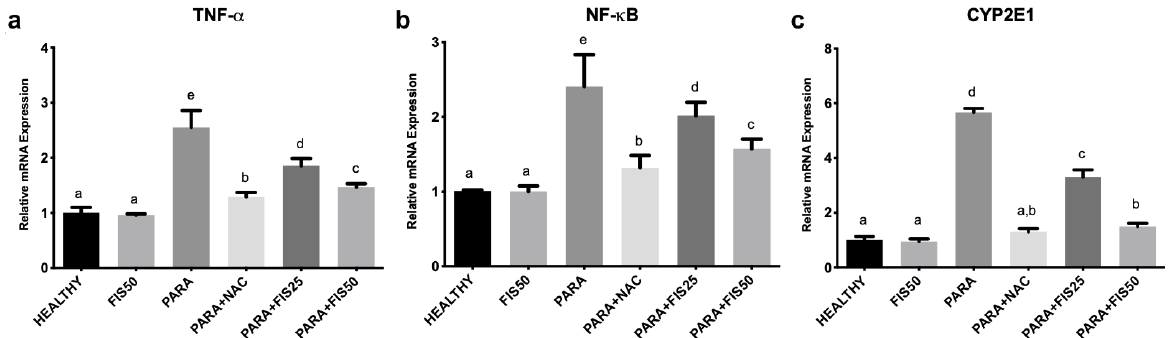
Figure 3. The Results of Relative mRNA Expression of TNF-α, NF-κB and CYP2E1. a: TNF-α, b: NF-κB, c: CYP2E1. Means with the same letter are not significantly different; means with different letters indicate significant differences between the groups according to the Duncan test (p < 0.05). Results are means ±